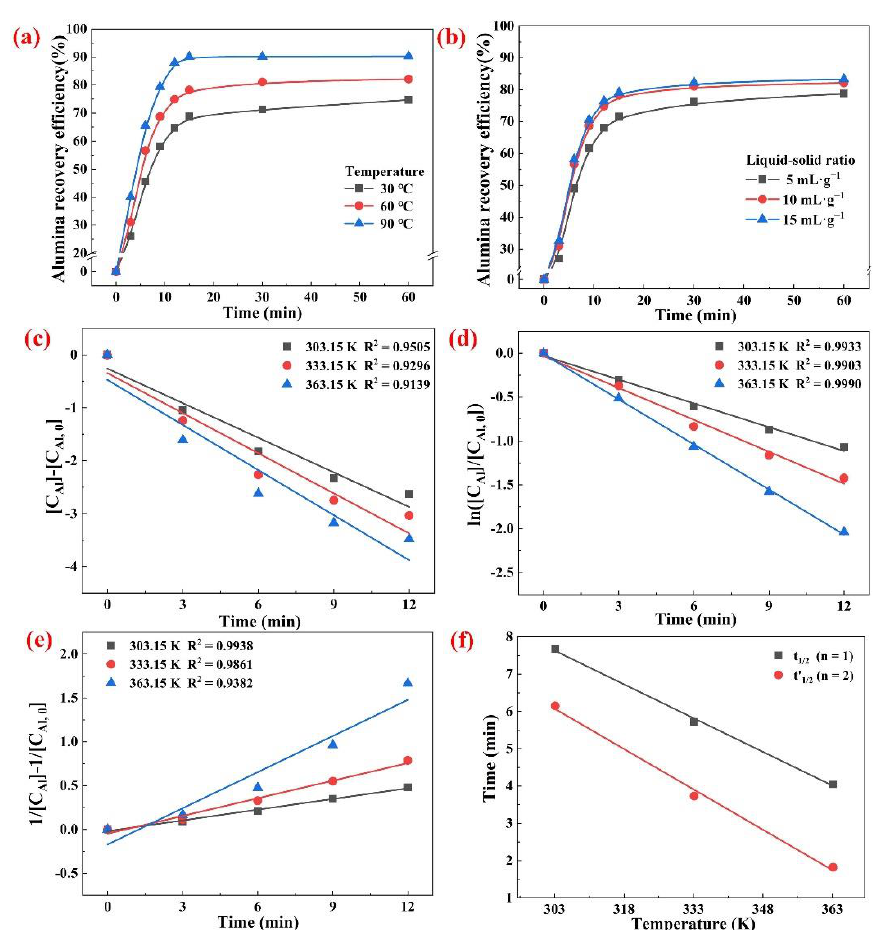
Figure 8. Recovery of Al in the roasting clinkers under different leaching temperatures ( a ) and L/S ratios ( b ), with fitting experimental data for different reaction orders: n = 0 ( c ), n = 1 ( d ) and n = 2 ( e ), and the half-life of leaching process at n = 1 and n = 2 ( f ).